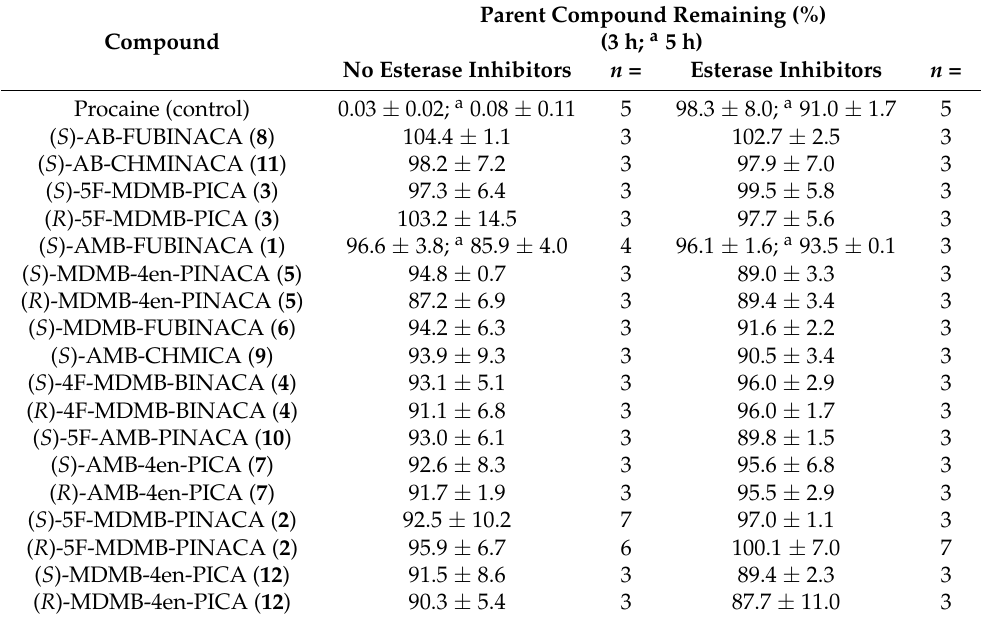
Table 2. Short-term plasma stability of tested SCRAs and positive control (procaine). a indicates data for 5 h